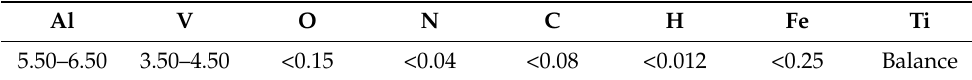
Table 1. Chemical composition of the titanium Ti-6Al-4V alloy (wt.%) [20]. Al V